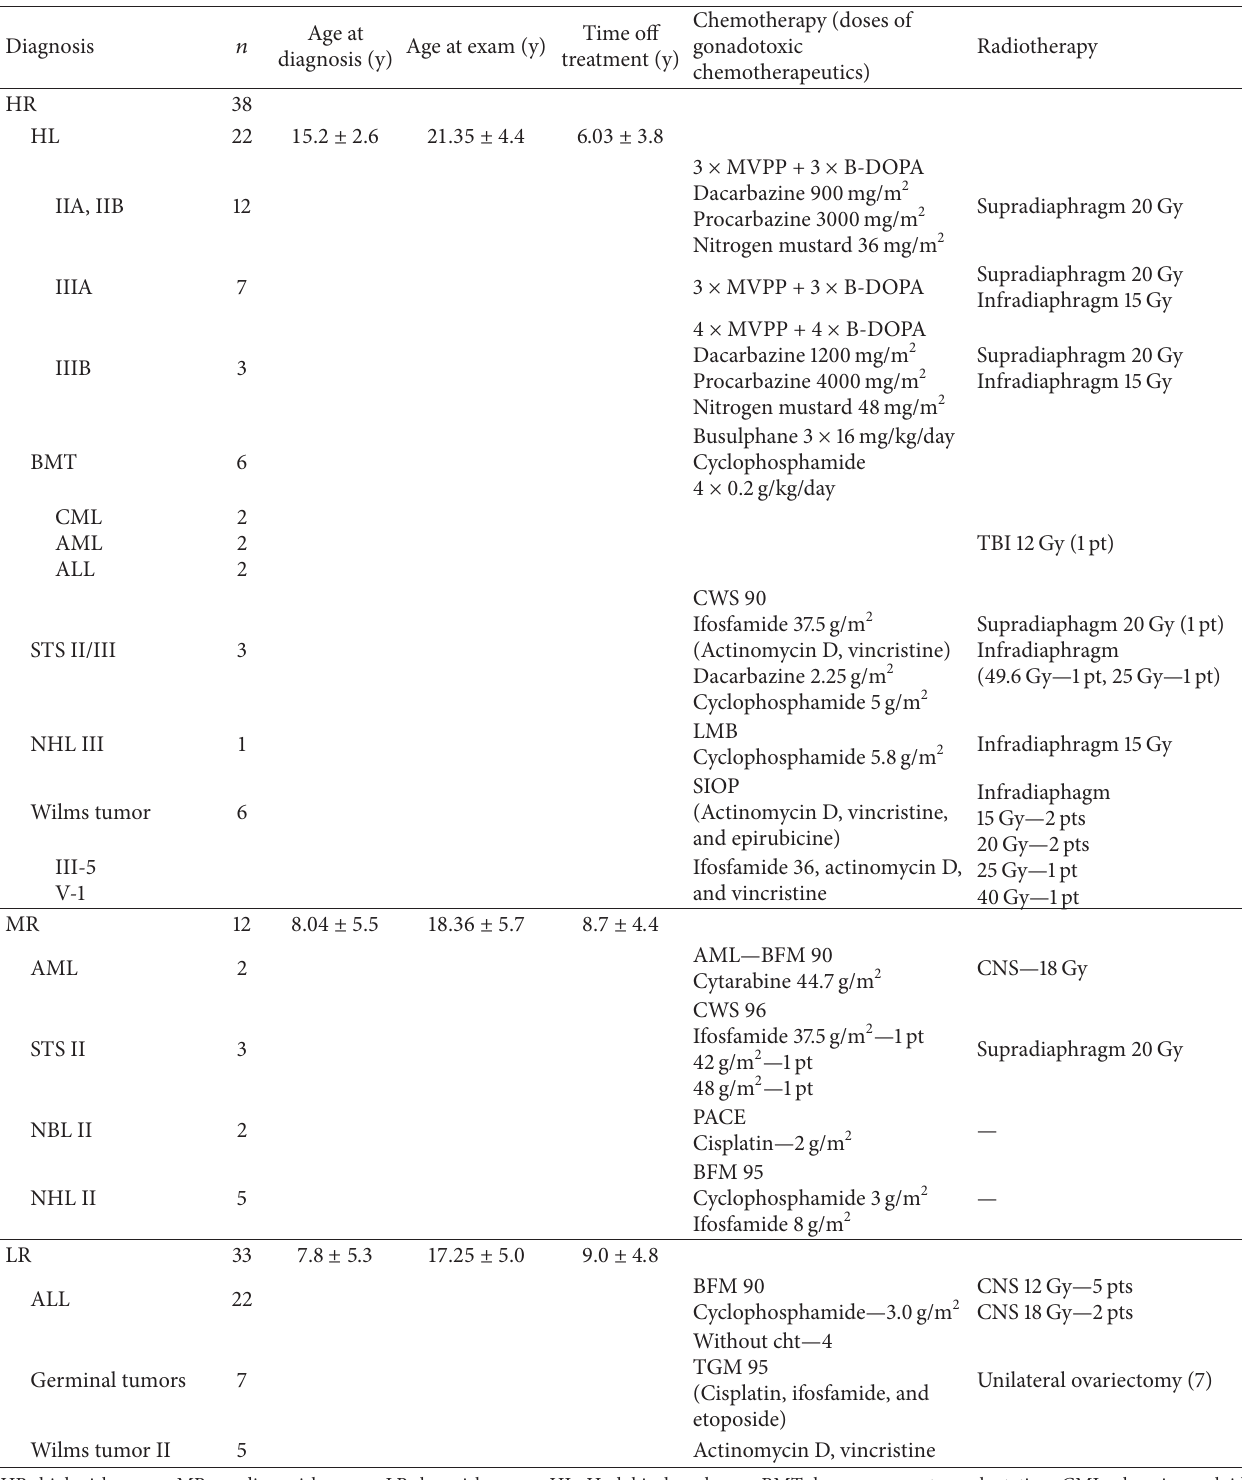
Table 1: Characteristic of patients classified according to different risk groups and related treatment.